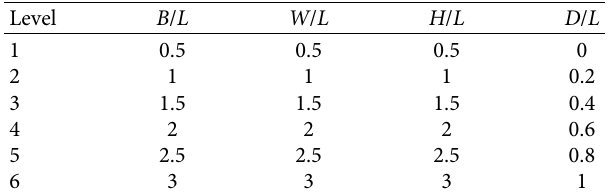
Table 1: The level of control parameters of the single factor